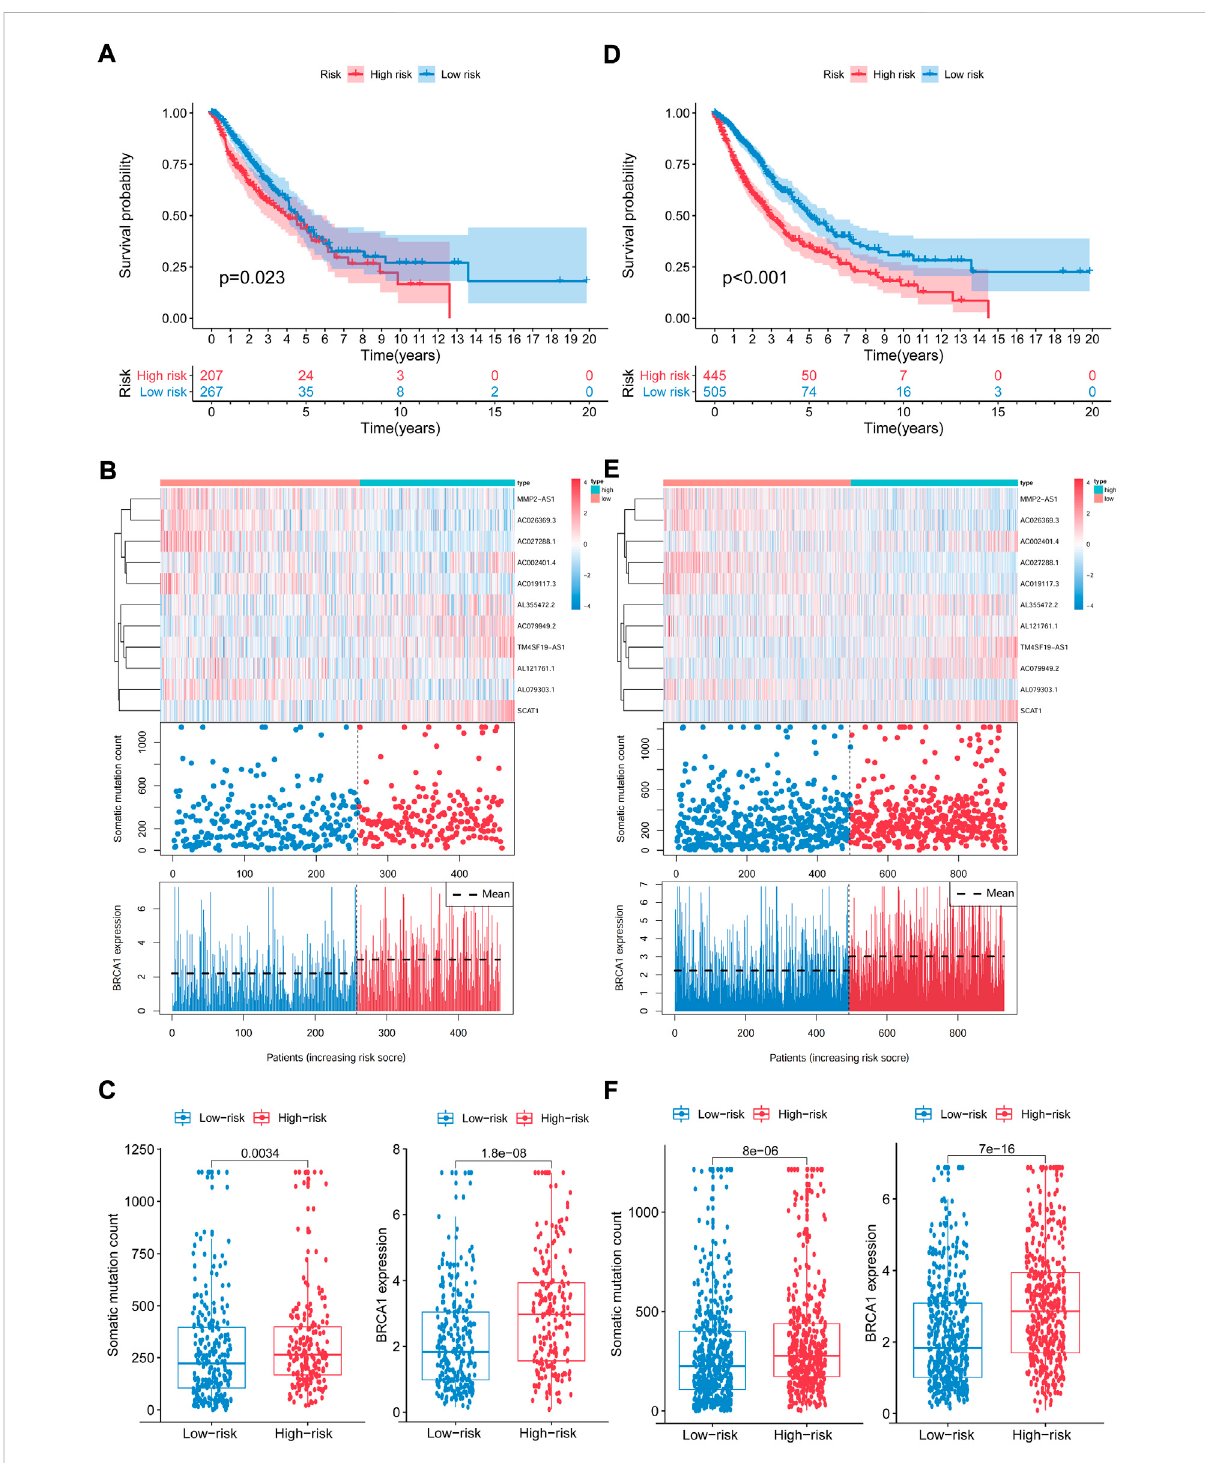
FIGURE 6 Capability validation oftheGIrLncSigin theTCGAset. Kaplan-Meierestimationofoverallsurvival for low- or high-risk patients inthetestset (A) and TCGA set (D) as forecasted by the GIrLncSig. The expression of GIrLncSig, the somatic mutation count and BRCA1 expression among the high- and low-risk groups inthetestset (B) and TCGAset (E) .Number ofsomaticmutations andBRAC1expressioninhigh- and low-risk groups inthetest set (C) and TCGA set (F) . Horizontal lines represents median values. The Mann – Whitney U test was used for statistical analysis. GIrLncRNAs, genomic instability-related lncRNAs